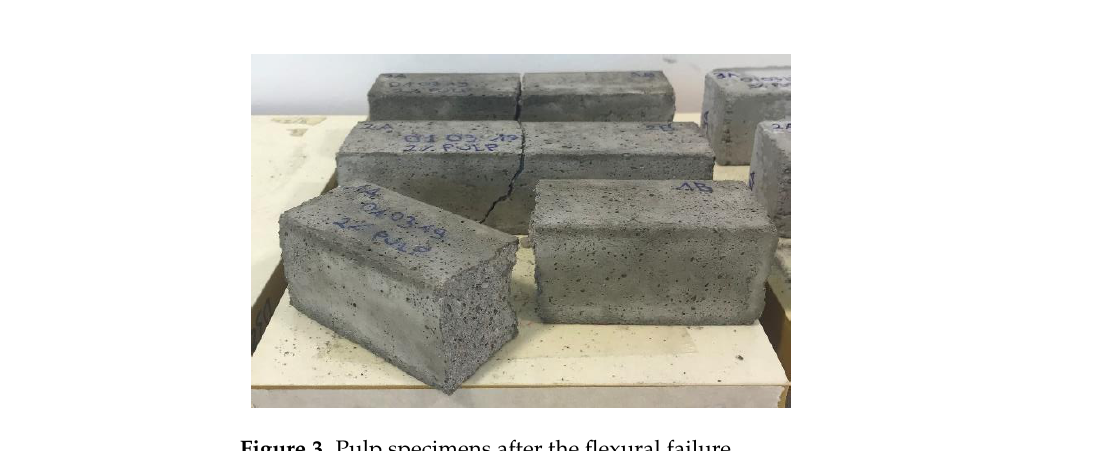
Figure 3. Pulp specimens after the flexural failure. Table 2. Average strengths of tested triplets.